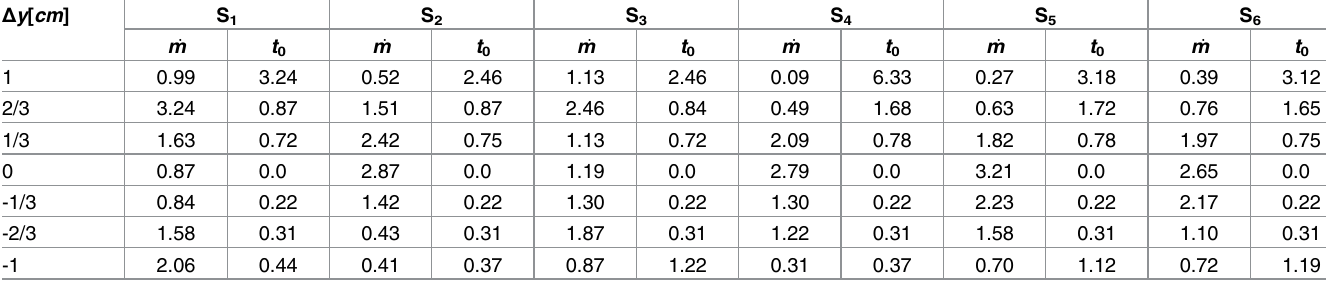
Table 3. Drug accumulation rate (1/s) and appearanceinstant (s), as obtained by varying the catheter